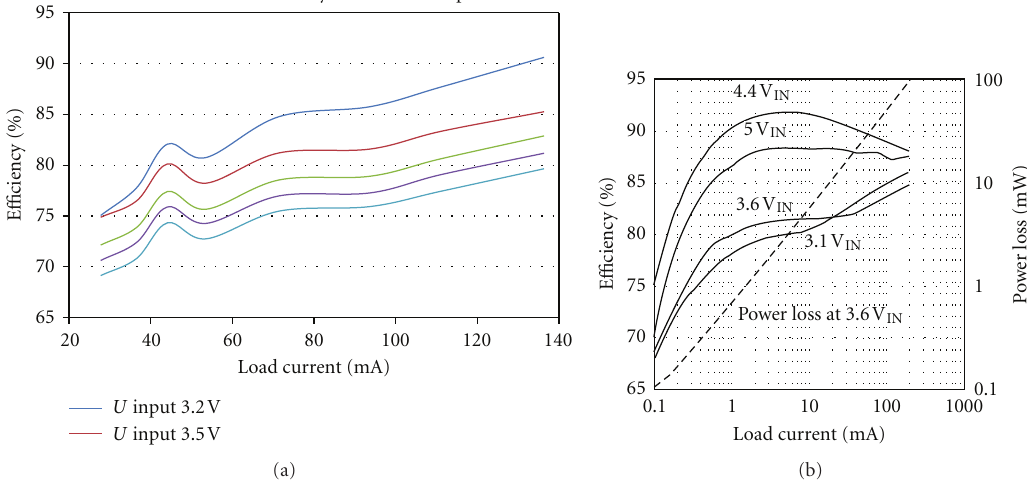
Figure 10: Comparison of real e ffi ciency of the designed DC-DC converter with NCP3063 (a) with the LTC3531-3 circuit from LT (b) [14].